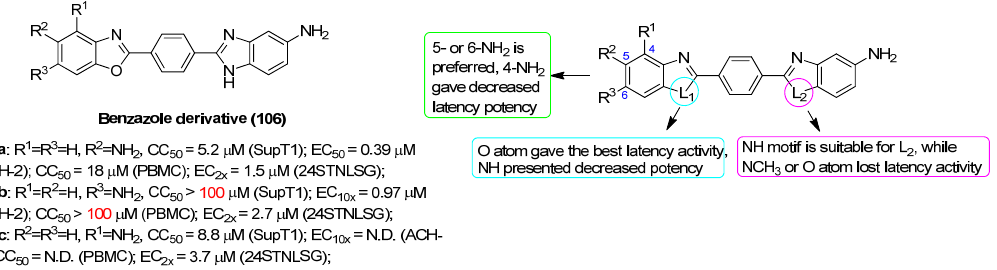
Figure 26. Chemical structures and preliminary SAR summary of benzazole derivative 106.